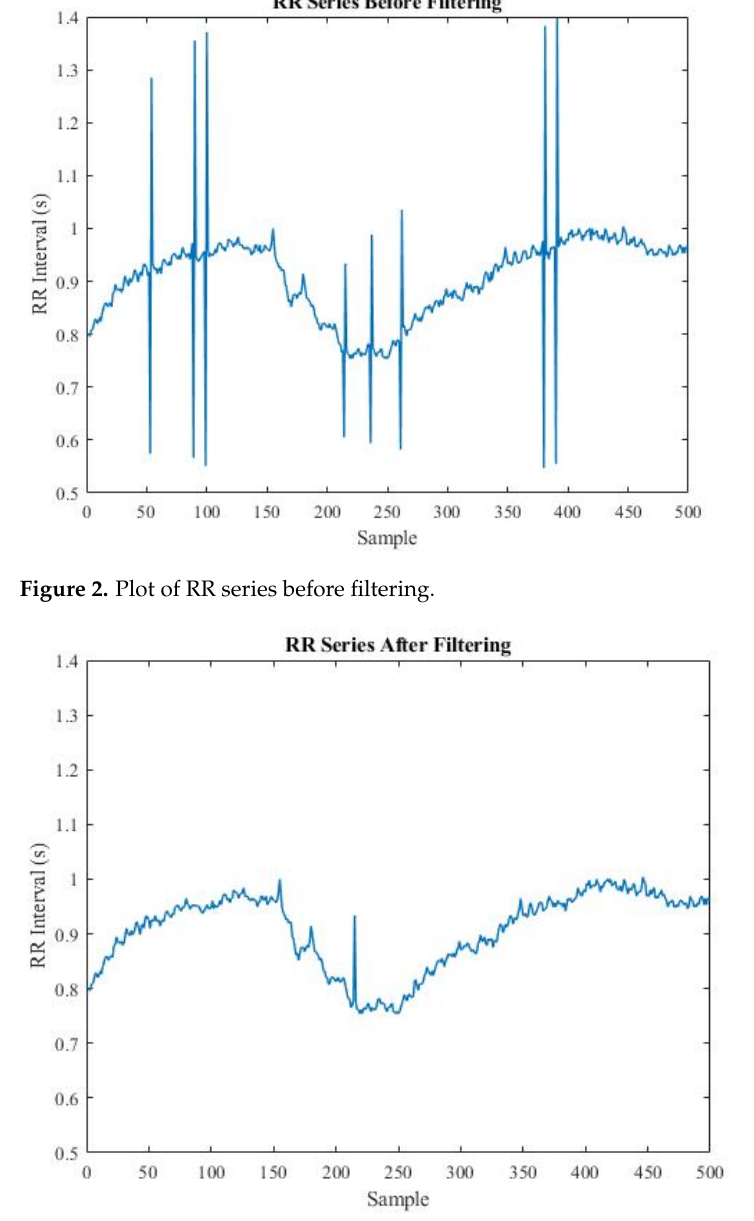
Figure 3. Plot of RR series after filtering.